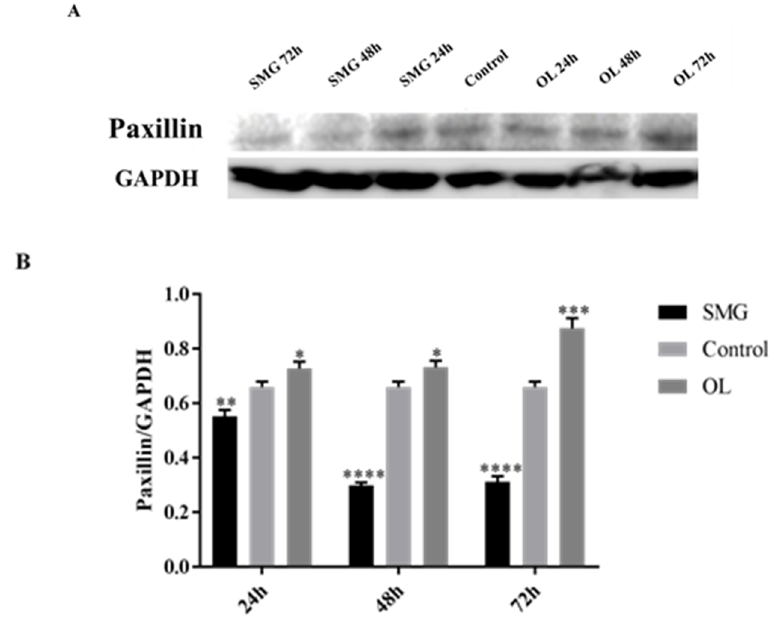
Figure 10. Western blot analysis of cells paxillin in HUVEC cells after mechanical changes. ( A ) Results for Western blots. ( B ) Reflective densitometry of Western blots. * p < 0.05, Significant difference; ** p < 0.01, *** p < 0.001 and **** p < 0.0001, extremely significant.